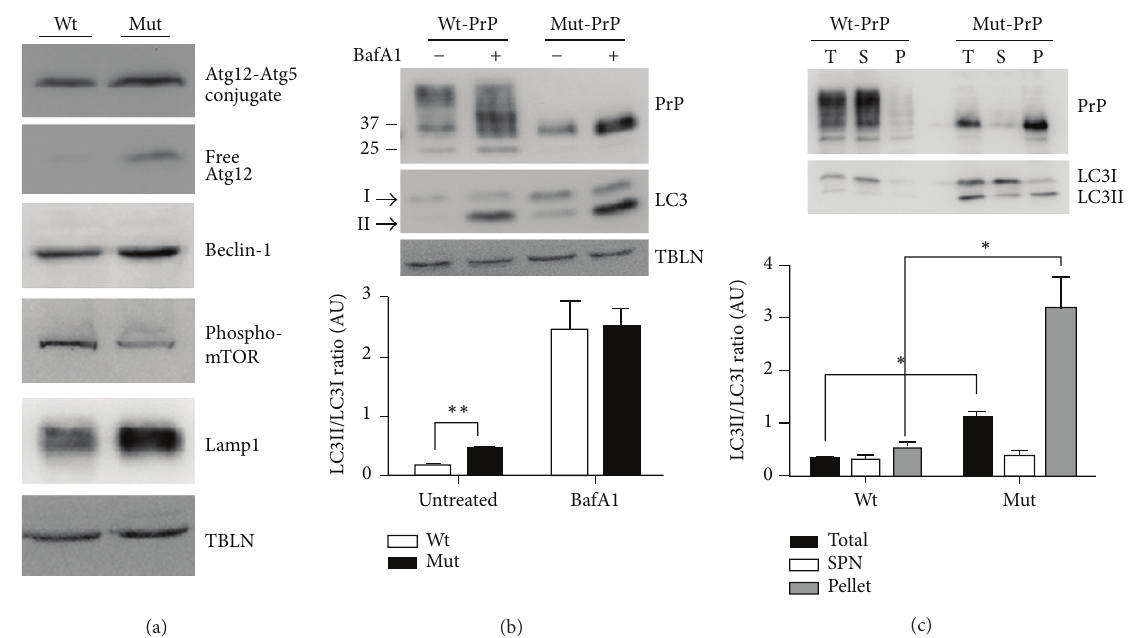
Figure 5: Mut-PrP expression activates autophagy. (a) Western blot of total lysates of N2a cells stably expressing Wt- or Mut-PrP engineered with the 3F4 epitope and probed for Atg12 (free and conjugated with Atg5), Beclin-1, phosphorylated mTOR, and LAMP-1. Loading was normalized for total protein. Tubulin (TBLN) is presented as a loading control. (b) Western blots of total lysates prepared from cells in (a) that were treated for 6h with vehicle or 50nM Bafilomycin A1 to limit LC3 degradation and probed for PrP with 3F4 mAb, LC3, and tubulin. PrP was detected by 3F4 mAb. The LC3II/LC3I ratio was measured by densitometry of each fraction, using Image One (BioRad) software from ECL developed Western blots, and displayed in the graph below ( ∗∗ 𝑃 = 0.002 , student’s 𝑡 -test, 𝑛 = 3 experiments). (c) Representative blots of total (T), supernatant (S), and pellet (P) fractions of cells in (a), following lysis and separation by centrifugation at 100,000 × g for 1h, were probed for PrP and LC3. LC3II/LC3I ratios for each fraction are presented in the graph below ( ∗ 𝑃 < 0.05 , student’s 𝑡 -test, 𝑛 = 3